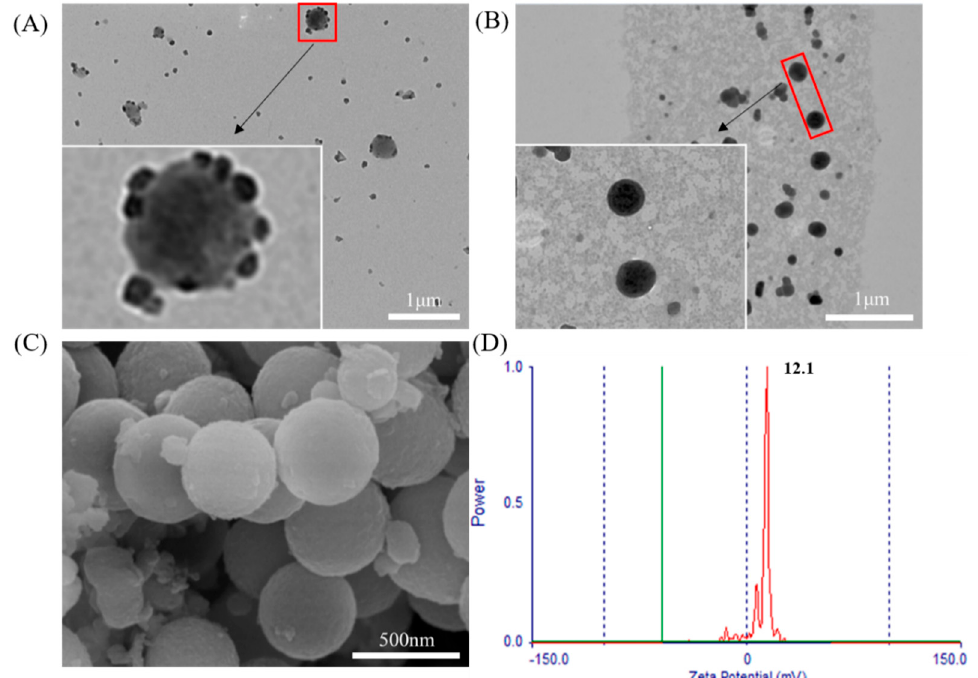
Figure 4. Transmission electron microscope morphology of NDV/SiO 2 nanoparticles: ( A ) transmission electron microscope image of NDV/SiO 2 nanoparticles; ( B ) NDV/SiO 2 @CMCS- N -2-HACC transmission electron microscope; ( C ) scanning electron micrograph of NDV/SiO 2 @CMCS- N -2-HACC; ( D ) Zeta potential diagram of NDV/SiO 2 @CMCS- N -2-HACC.